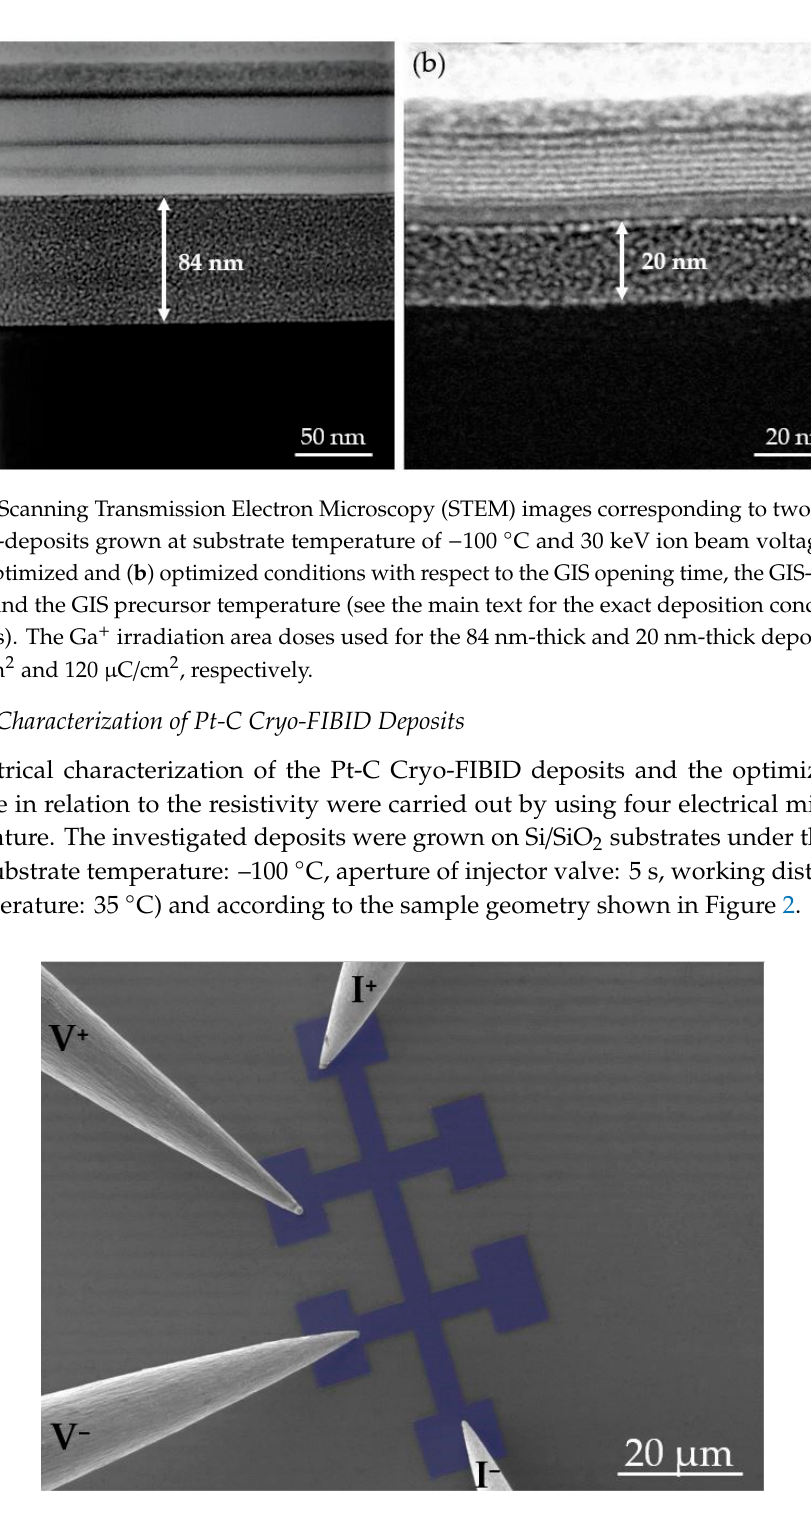
Figure 2. Artificially colored Scanning Electron Microscopy (SEM) micrograph of one of the devices electrically measured at room temperature with the four probes. These Pt-C Cryo-FIBID deposits had an area of ~1400 µ m 2 and the irradiation time was ~5 min, which corresponds to an ion dose of 210 µ C / cm 2 (an ion beam current of 10 pA was